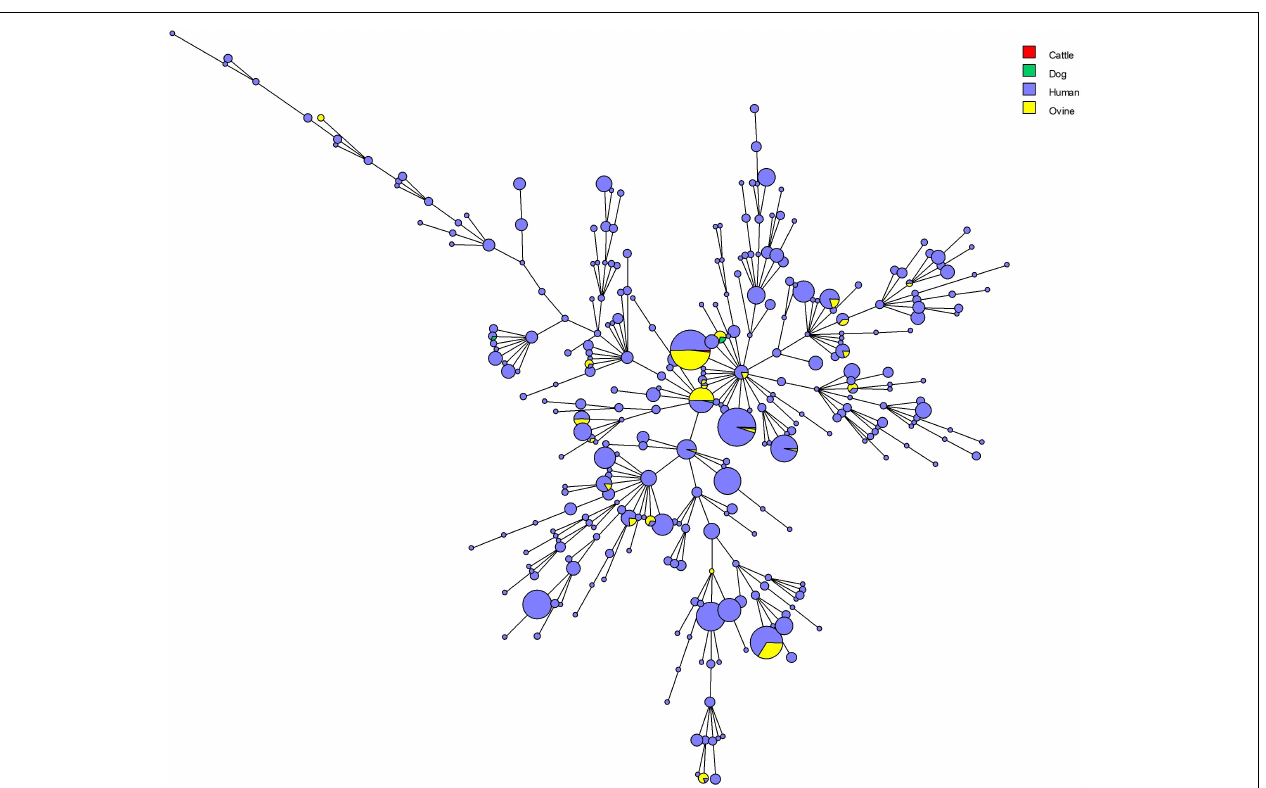
FIGURE 5 | Maximum parsimony analysis using MLVA16 data from 1455 B. melitensis strains isolated from humans and animals in Kazakhstan. The color code reflects the host origin (cattle: 1 strain, genotype 116; dog: 5 strains, 2 belong to genotype 111, 3 to genotype 116; human: 1327 strains; sheep: 122